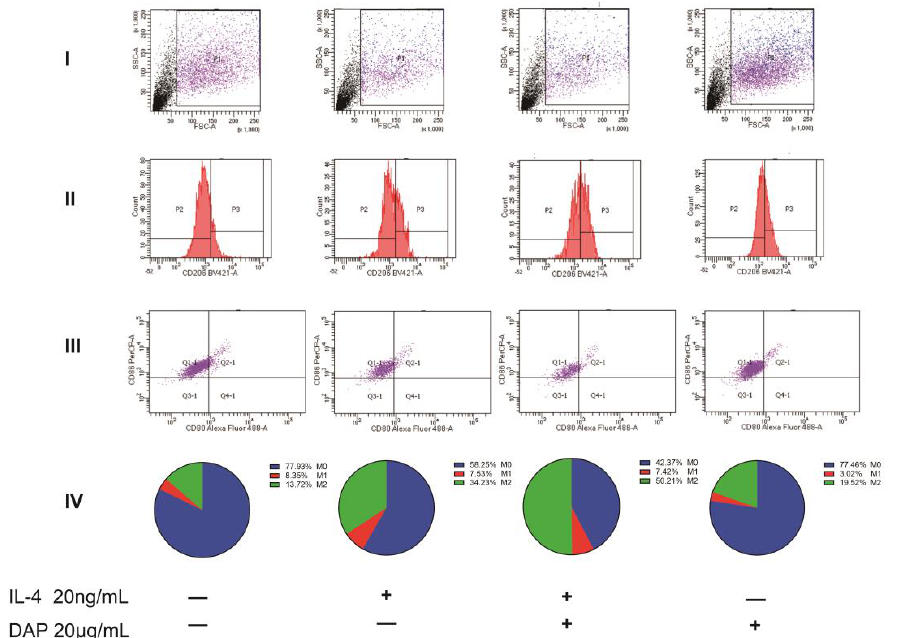
Figure 7. Effect of daphnetin on the IL − 4 − induced polarization of HMC3 cells. ( I ) The range of de- tection circled by flow cytometry. ( II ) Negative region P2 and positive region P3 of CD206. ( III ) Expression of CD80 and CD86 in cells within the P2 region. ( IV ) Percentage expression of M0, M1, and M2 within the samples by flow cytometry ( n = 3).